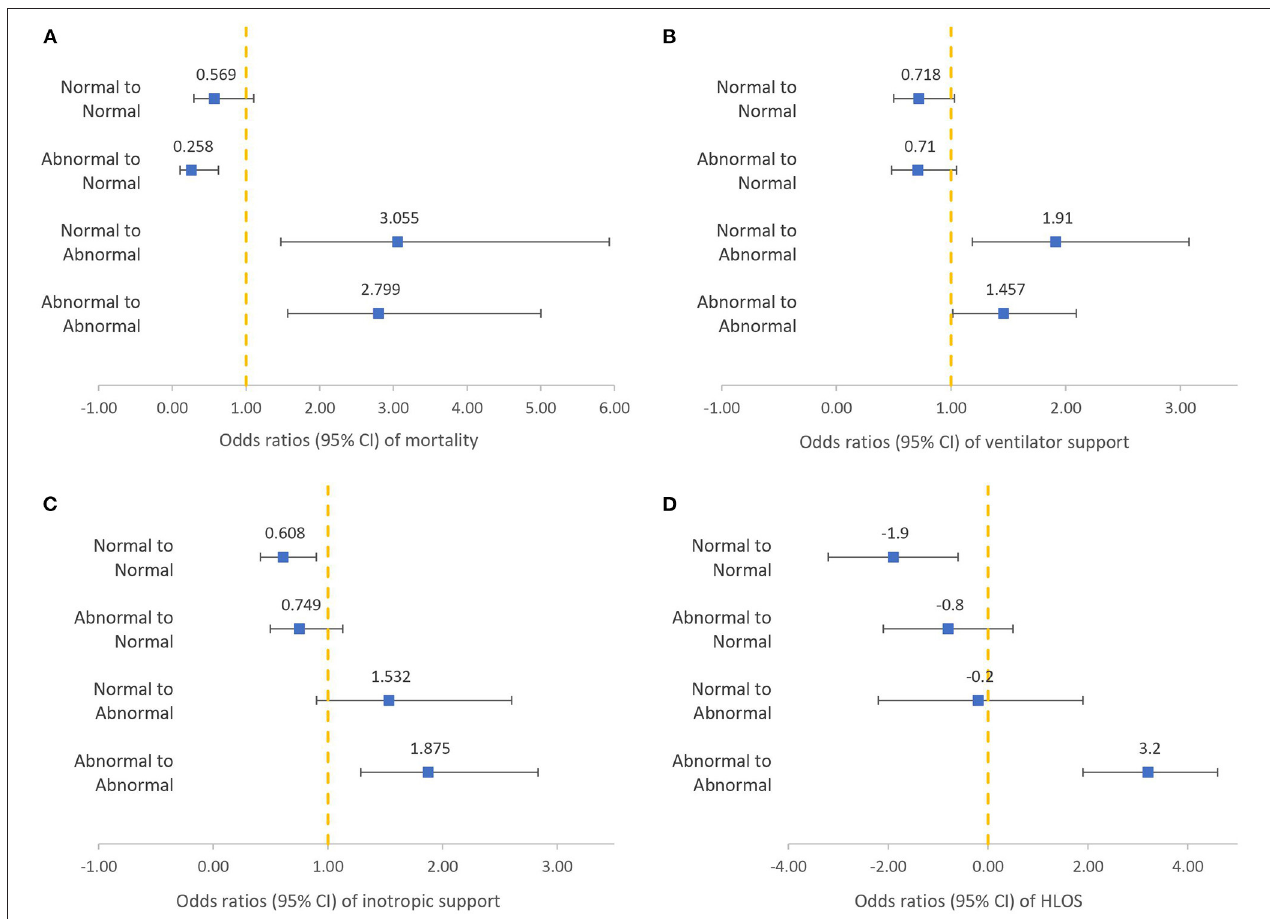
FIGURE 2 | Logistic regression of different shock index, pediatric age-adjusted trends to clinical outcomes after adjusting for confounding factors: mortality (A) , ventilator support (B) , inotropic support (C) , HLOS (D) .